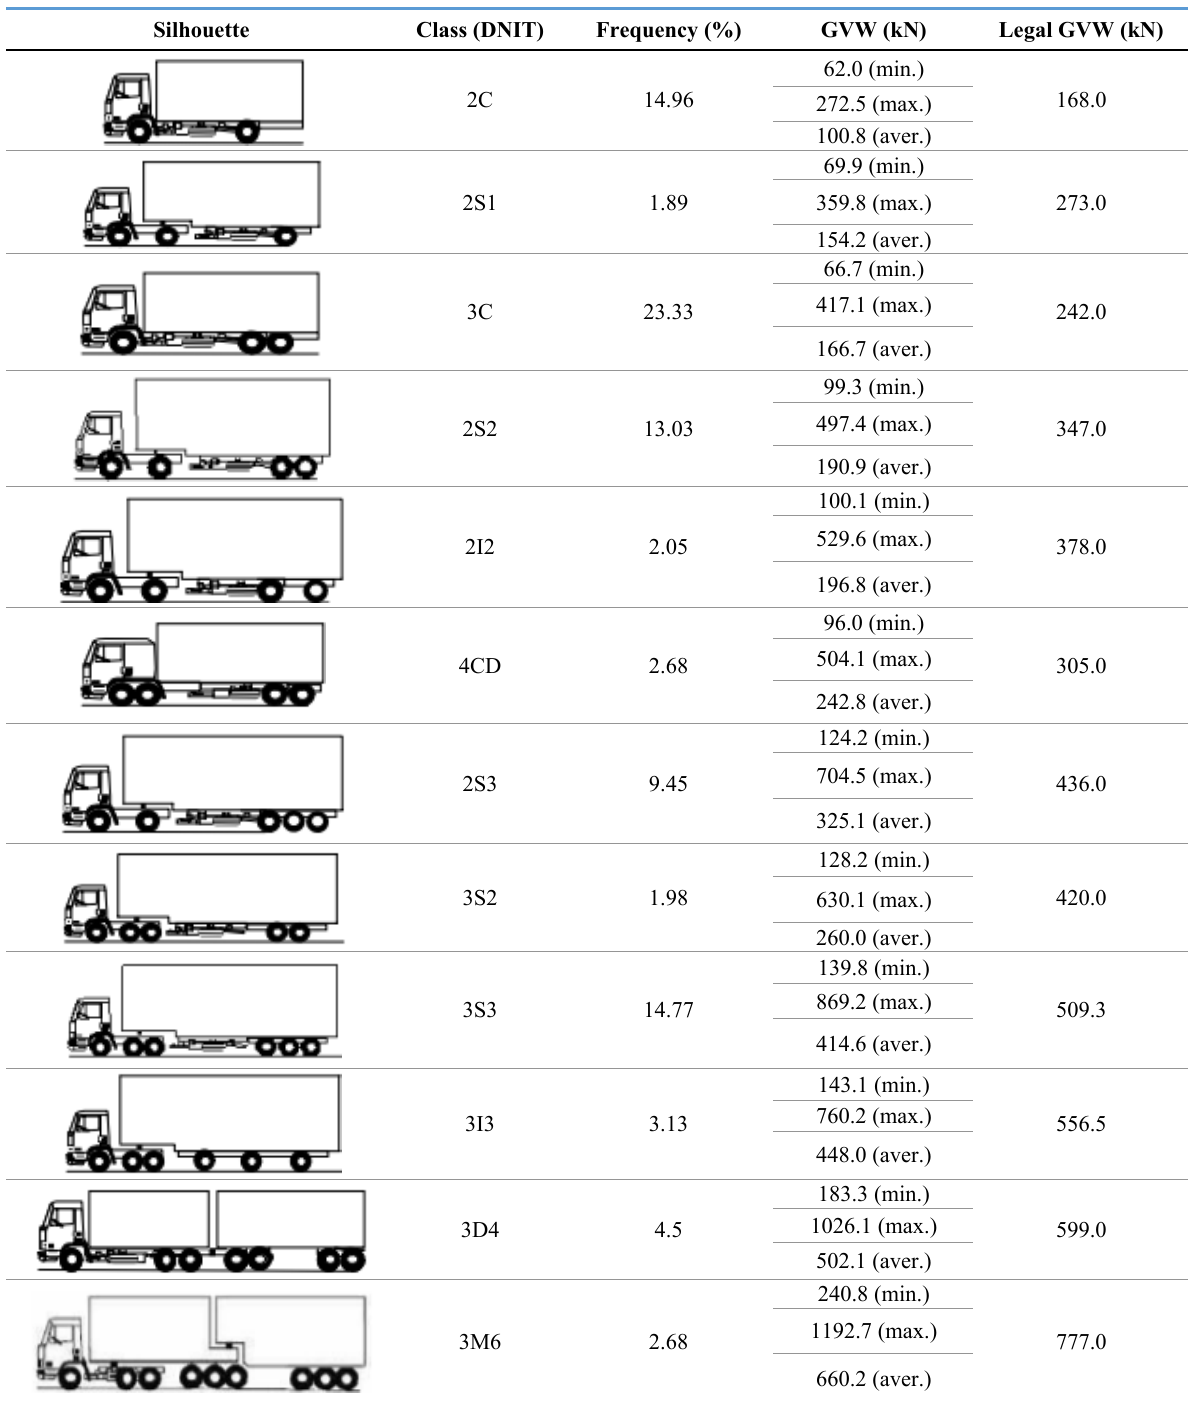
Table 4. Statistics for twelve most frequent classes of BR-381 from September 2016 to May